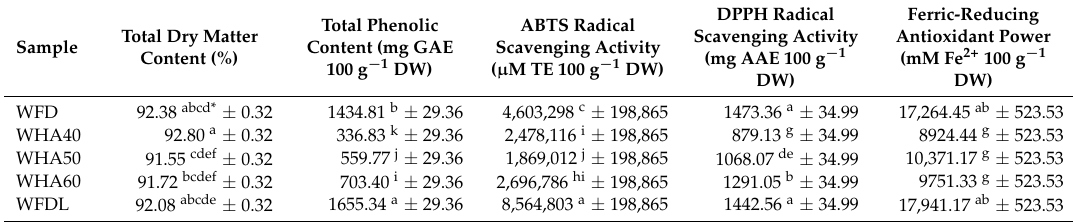
Table 3. The total dry matter content, total phenolic content, ABTS radical scavenging activity, DPPH radical scavenging activity, and ferric-reducing antioxidant power of the yacon chips produced from white yacon